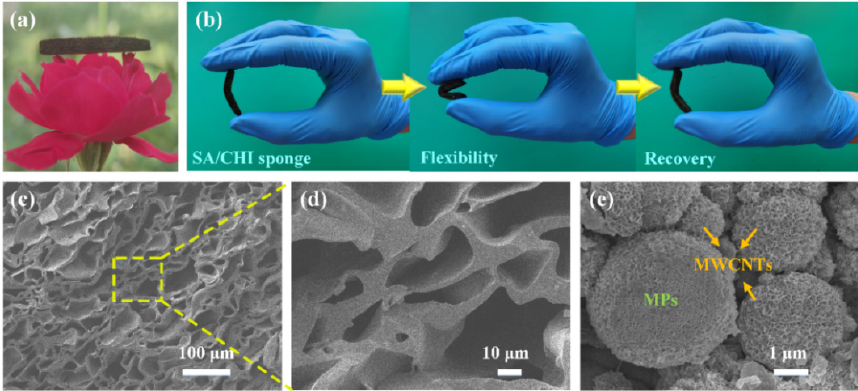
Figure 2. ( a ) The as-prepared SA3/CHI2 sponge put on the petals. ( b ) Flexibility and recoverability of SA3/CHI2 sponge. SEM images of ( c , d ) SA3/CHI2 sponge and ( e ) Micron CI and nanoscale Fe 3 O 4 particles dual-coated with